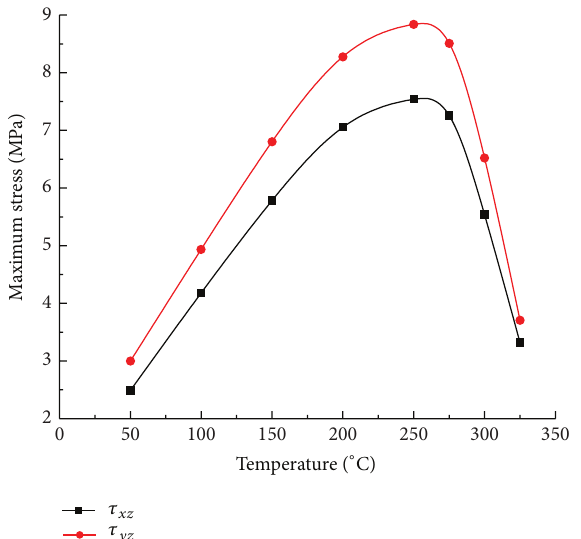
Figure 7: The variation of maximum shear stress when considering the change of Elastic modulus and Poisson ratio with temperature.